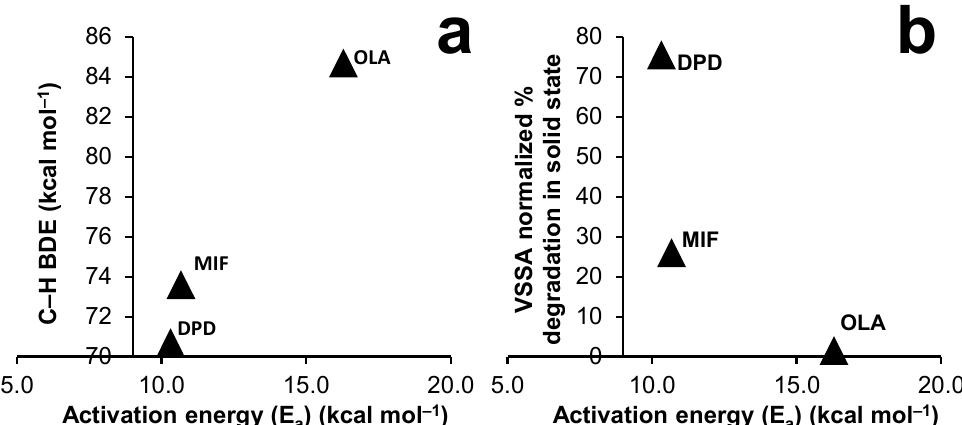
Figure 6. Plots demonstrating ( a ) the relationship between the E a of drug autoxidation in NMP solution (RapidOxy ® stress) and their C–H BDE and ( b ) a comparison between E a of drugs autoxidation in NMP solution and volume-specific surface area normalized degradation extent in the solid